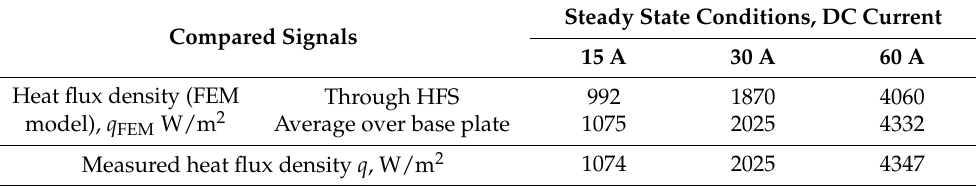
Table 5. Comparison of the heat flux density test results with the numerical modeling.